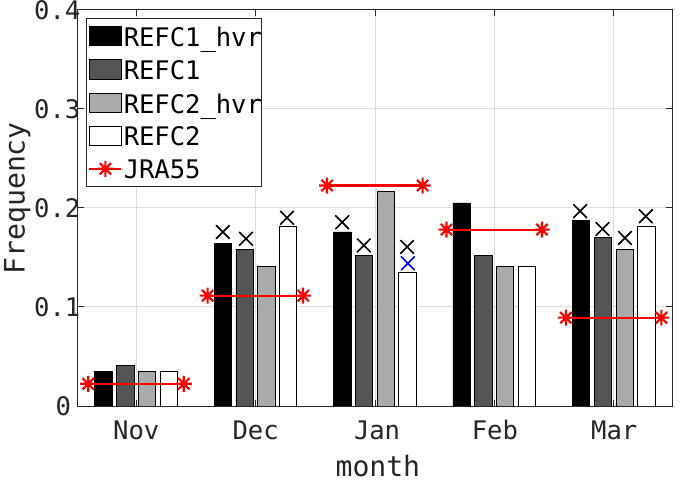
Figure 3. Monthly frequency of SSWs. The red lines show the frequencies corresponding to the reanalysis data. A black “ × ” indicates that frequency in a simulation is significantly different from JRA55 at the 5% level. The significance was computed according to Appendix A [30]. A blue “ × ” indicates the same between the different